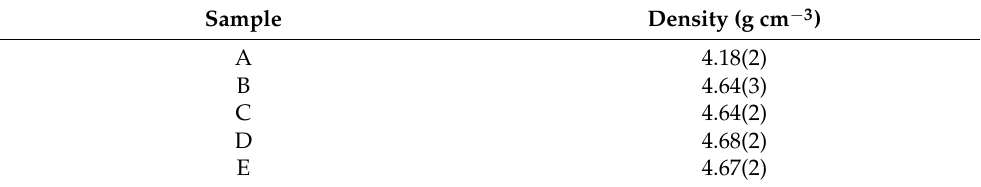
Table 5. Densities of Samples A – E.